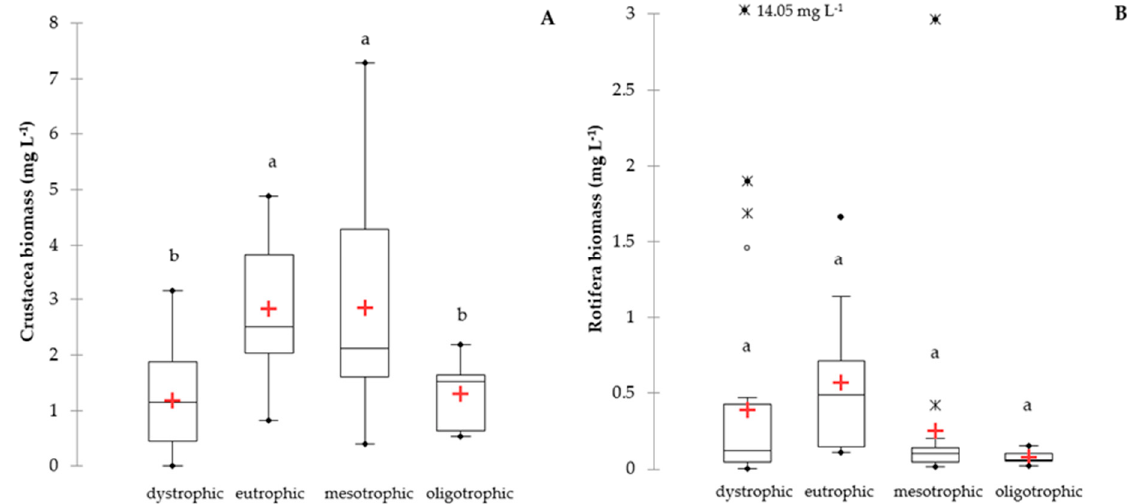
Figure 4. Average biomass of crustacean ( A ) and rotifers ( B ) from vertical profiles of lakes with different trophic status. Descriptive statistics as in Figure 2.